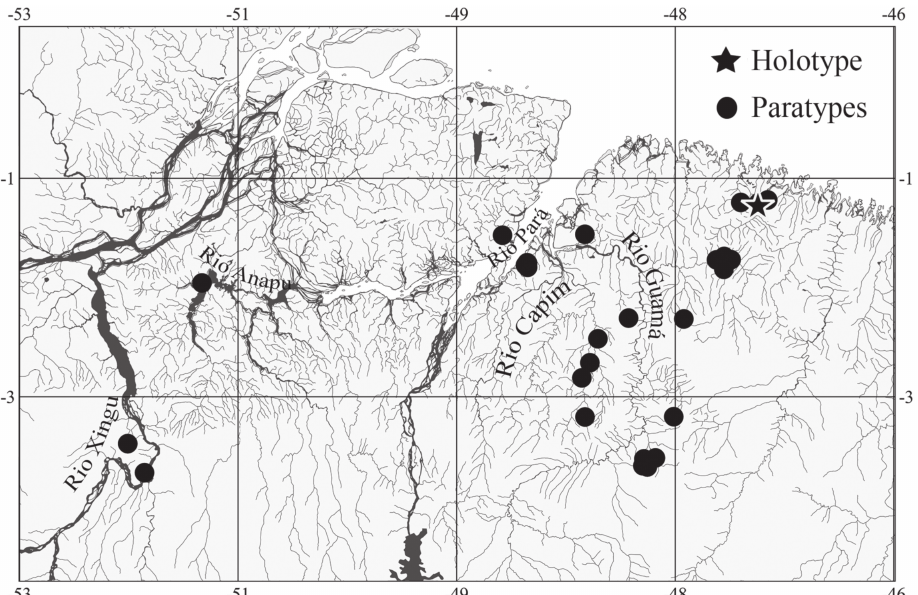
Fig. 4. Map of northern portion of South America, with the distribution of Pyrrhulina capim , new species. The polygons represent the localities of the holotype and